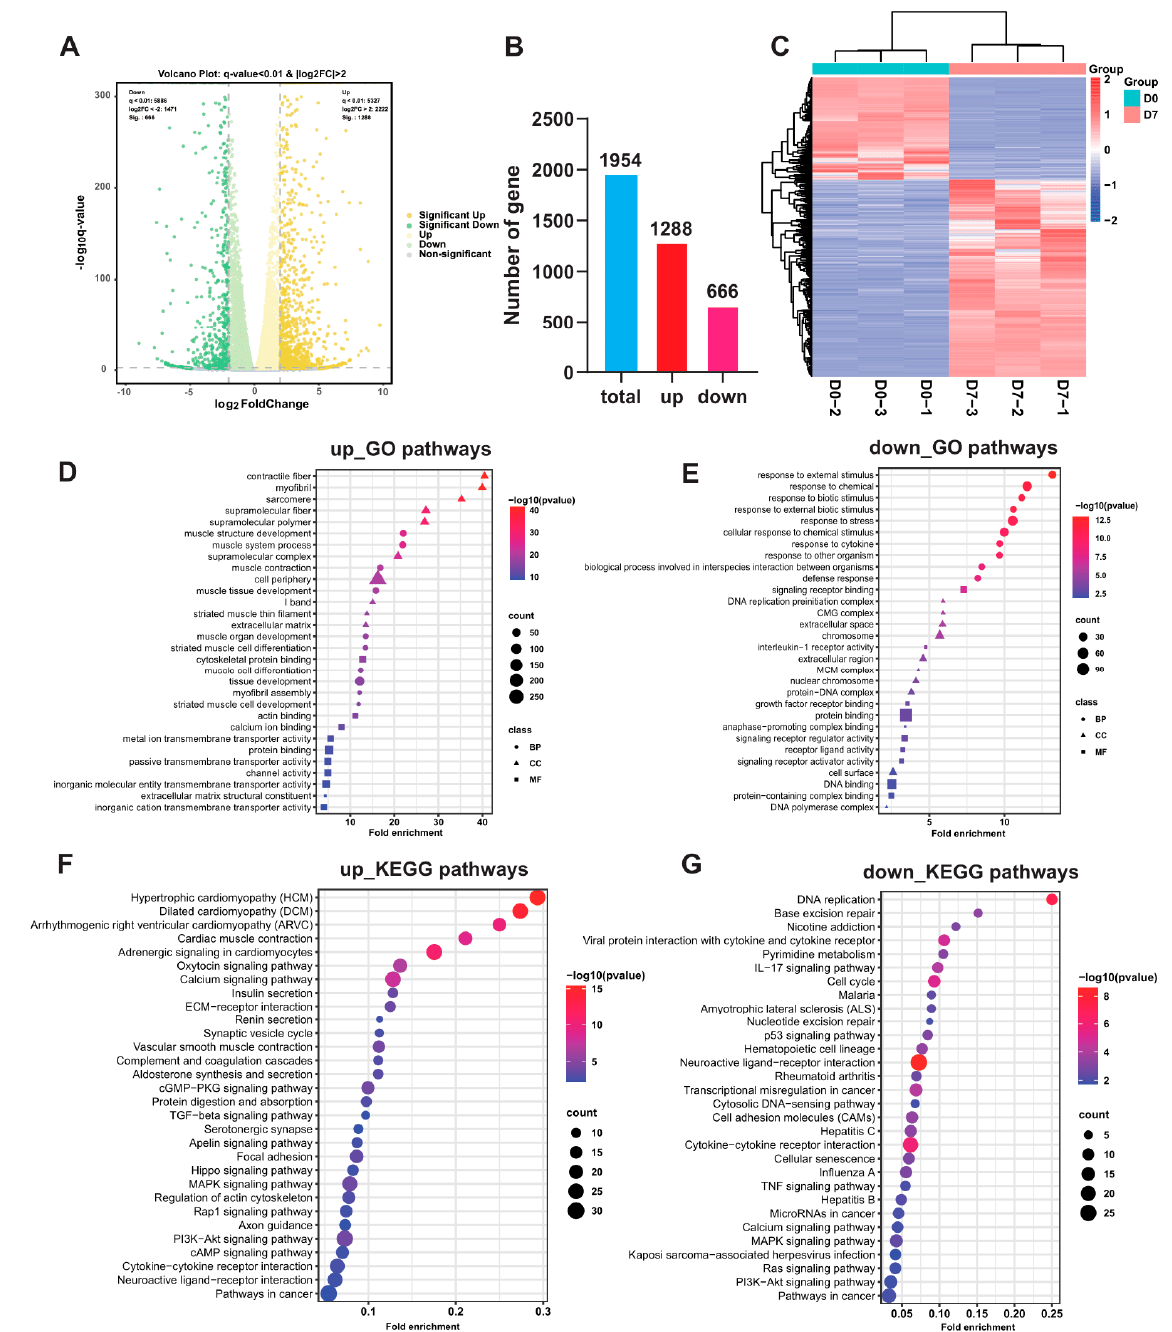
Figure 2. The expressions and functional analyses of the DEGs in SMSCs at the proliferation and differentiation stages. The schemes follow the same formatting. ( A ) The volcano plot of DEGs between groups D0 and D7 groups |Log2 fold change| > 2, q < 0.01; the q value was adjusted to the p value by multiple hypothesis testing. ( B ) The number of DEGs. ( C ) Heat maps showing DEGs were expressed between the D0 and D7 groups, red denotes a high level of expression, whereas blue denotes a low level of expression. ( D ) GO analysis showing the top 30 pathways of the upregulated DEGs. ( E ) GO analysis showing the top 30 pathways of the downregulated DEGs. ( F ) KEGG analysis showing the top 30 pathways of upregulated DEGs. ( G ) KEGG analysis showing the top 30 pathways of downregulated DEGs ( p < 0.05). Note: The size of the circle indicates the number of annotated differentially expressed genes, and the color represents the − log p